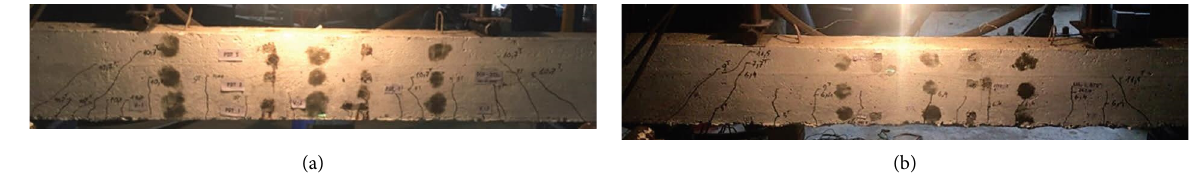
Figure 6: Observed cracks in the concrete beams: (a) there were cracks in the concrete beam (Beam 1); (b) there were cracks in the concrete beam (Beam 2).